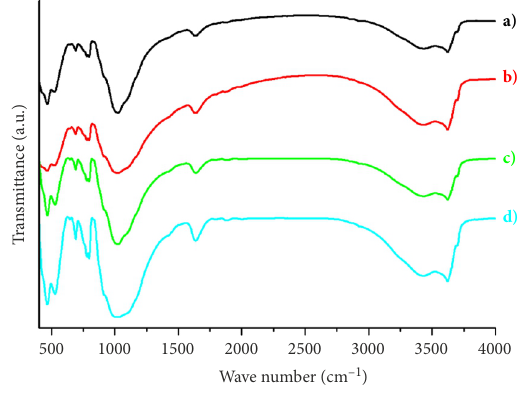
Figure 7. FT-IR spectra of: a – S0; b – S1; c – S3;